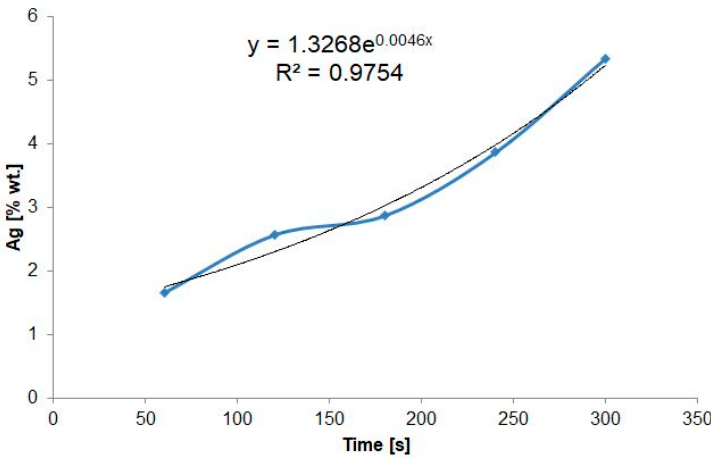
Figure 6. Chart of deposition duration dependency on the silver weight content in produced AgNPs/TNT platforms.